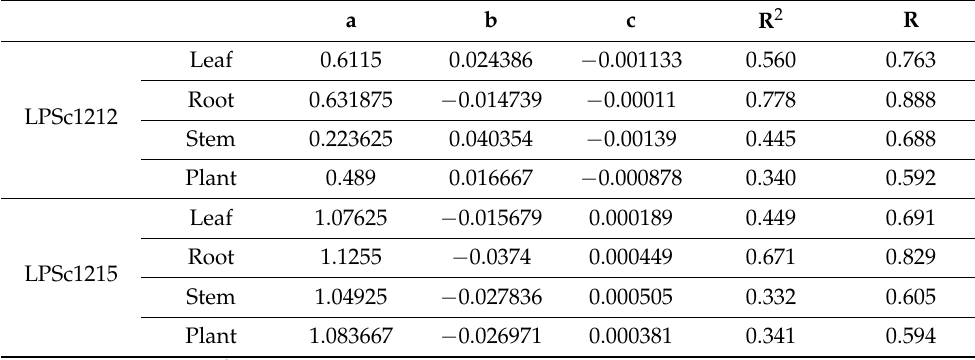
Figure 1. Endophytic colonization percentages (mean ± SE) of tobacco plants. ( A ) 7 days after treatment, ( B ) 14 days after treatment, ( C ) 21 days after treatment and ( D ) 28 days after treatment. Different letters indicate significative differences among strains on each date (Tukey test p < 0.05). Table 3. Coefficients of the polynomial exponential second order models (a + b × time + c × time 2 ) fitted to the colonization data of strains LPSc 1212 and LPSc